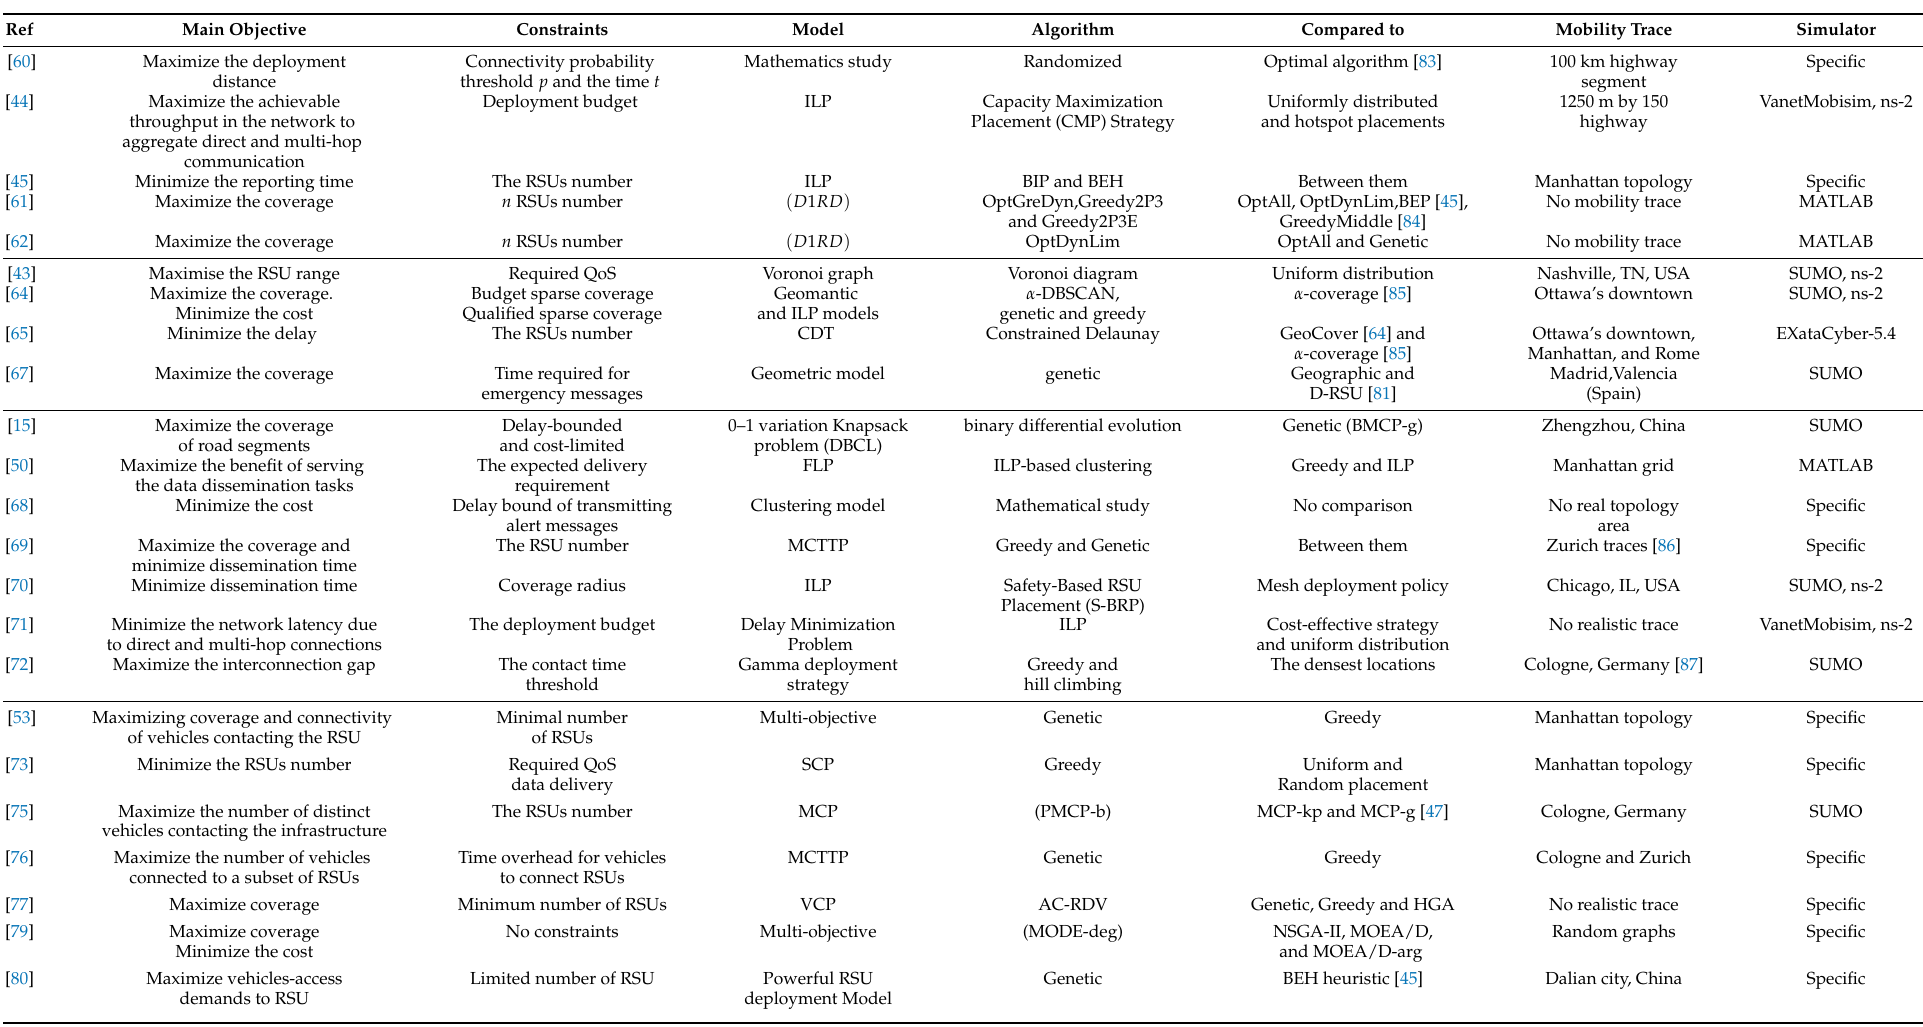
Table 2. A qualitative overview of static deployment